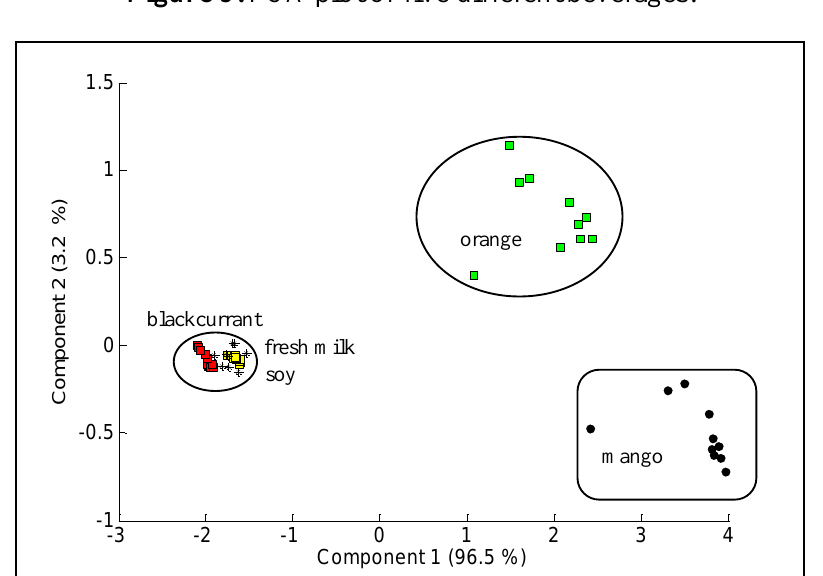
Figure 9. PCA plot of five different